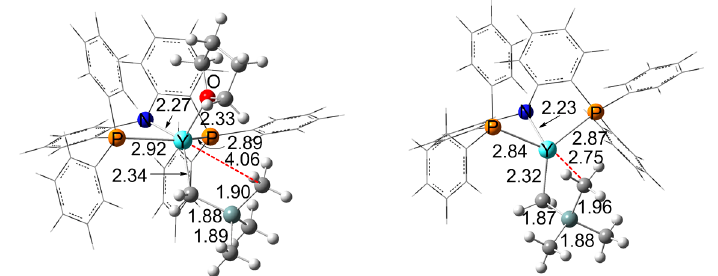
Figure 1. Optimized structures of cationic species thf A ( left ) and A ( right ) (distances in Å).